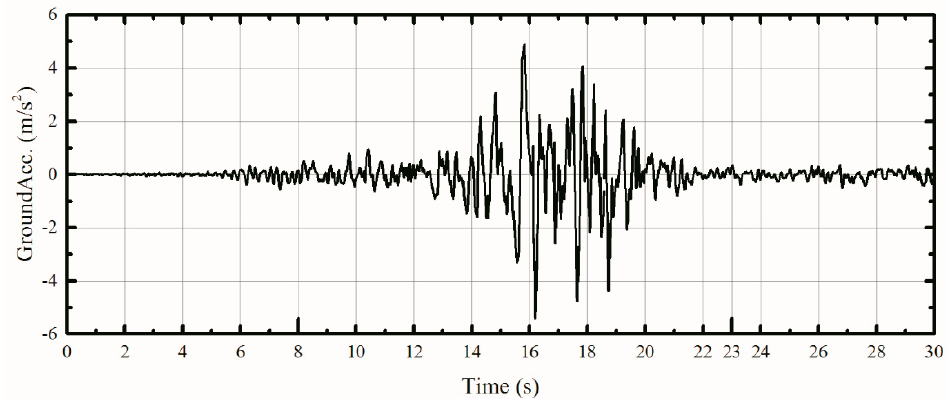
Figure 9. An SDOF with a bilinear inelastic behavior.